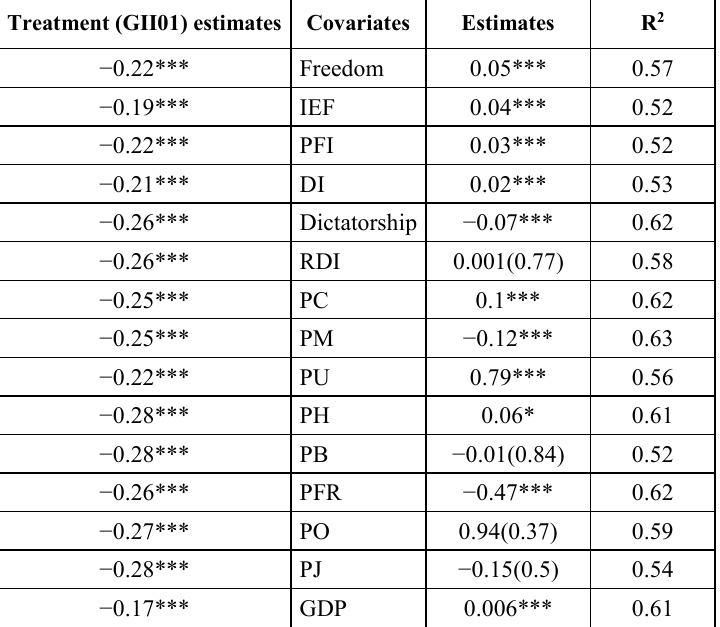
Table 5. PSM Results: Education Index as an Outcome, Gender Inequality Index as a Treatment Treatment (GII01) estimates Covariates Estimates R 2 − 0.22*** Freedom 0.05*** 0.57